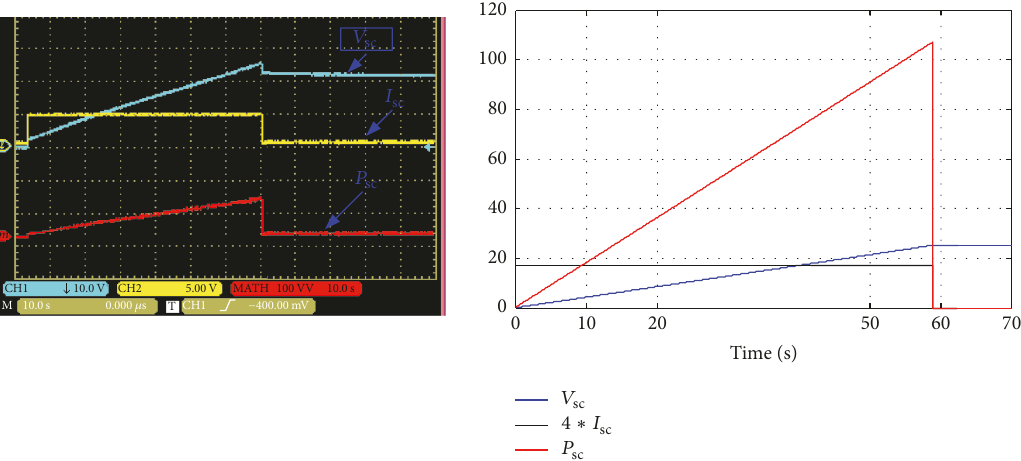
Figure 12: Voltage, current, and power waveforms of the ultracapacitors (charging mode-series).